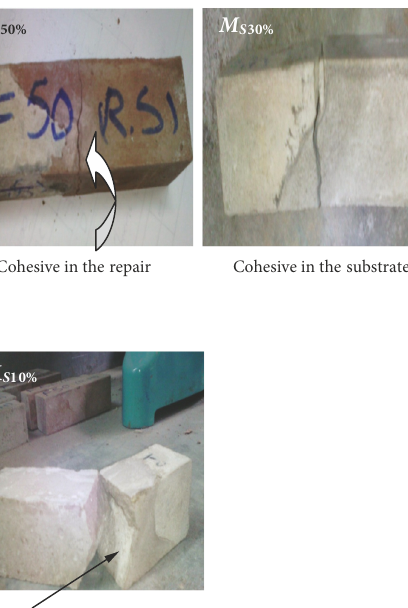
Adhesive Failure at the interface of mortar/substrate Figure 7. Failure mode on the mortar